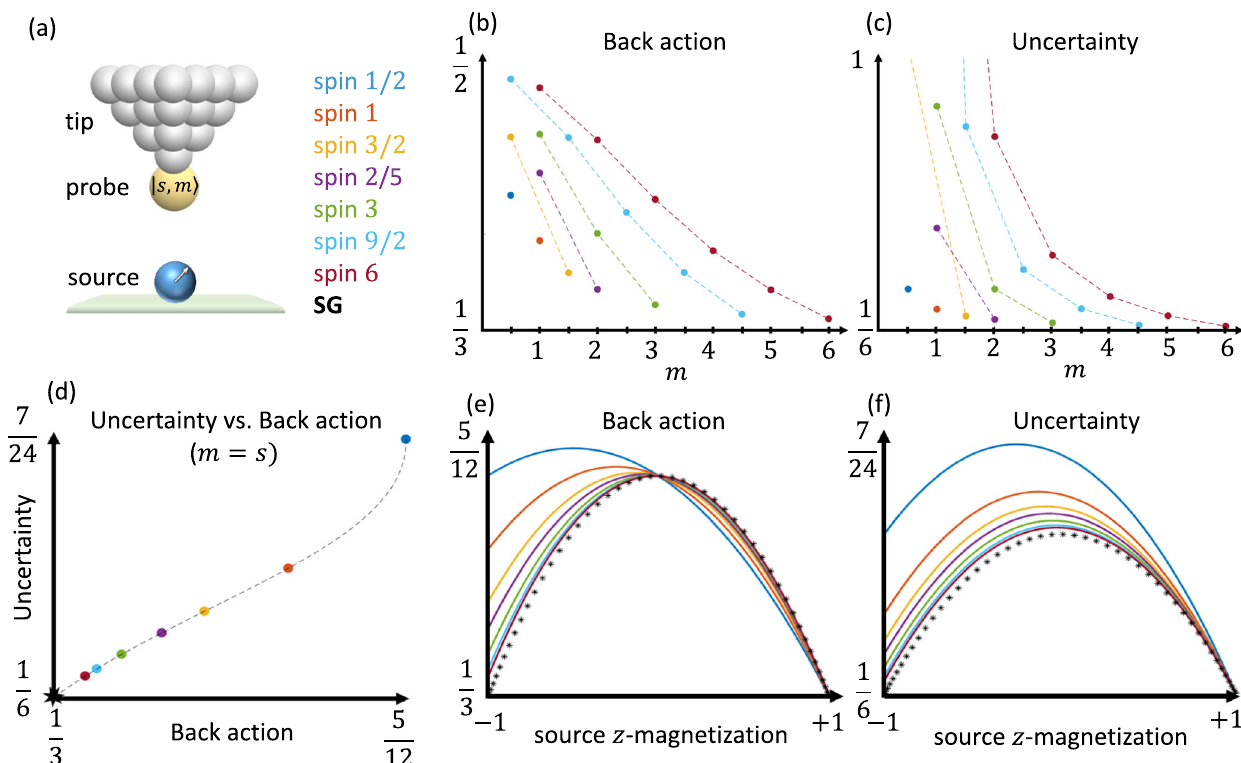
Fig. 3 Quantum measurement of a spin using higher spin probes. Higher spins provide a better measurement performance. a Setup schematics of a high-spin probe with total spin s and z -component m . The color legend for panels ( b – f ) is shown on the right. b , c Back action ( b ) and uncertainty ( c ) for probes of different spin numbers and as a function of m , the probe ’ s spin z component. The values of the criteria are averaged over all possible initial source spin states (the entire Bloch sphere). The vertical axis in ( c ) was cut in the value 1 for fi gure clarity. d Average uncertainty vs. average back-action plots for each s (with m = s ), connected in dashed black line using the theoretical formulas. Both measurement criteria are improved by using higher spins. e , f Back action ( e ) and uncertainty ( f ) for different values of s (with m = s ), as a function of the initial z -magnetization of the source. Note the convergence to the Stern-Gerlach (SG) type measurement (black